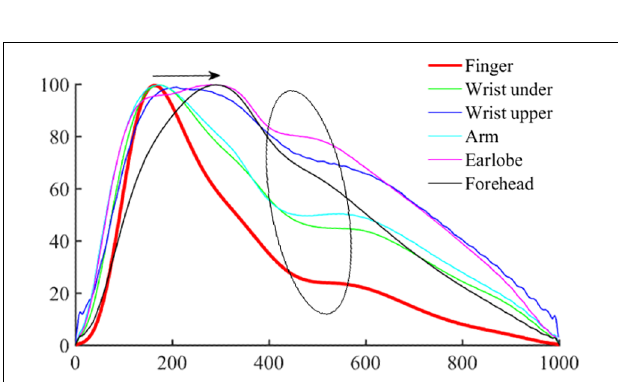
FIGURE 3 | Normalized and averaged PPG waveforms of one subject from the six body sites under normal breathing